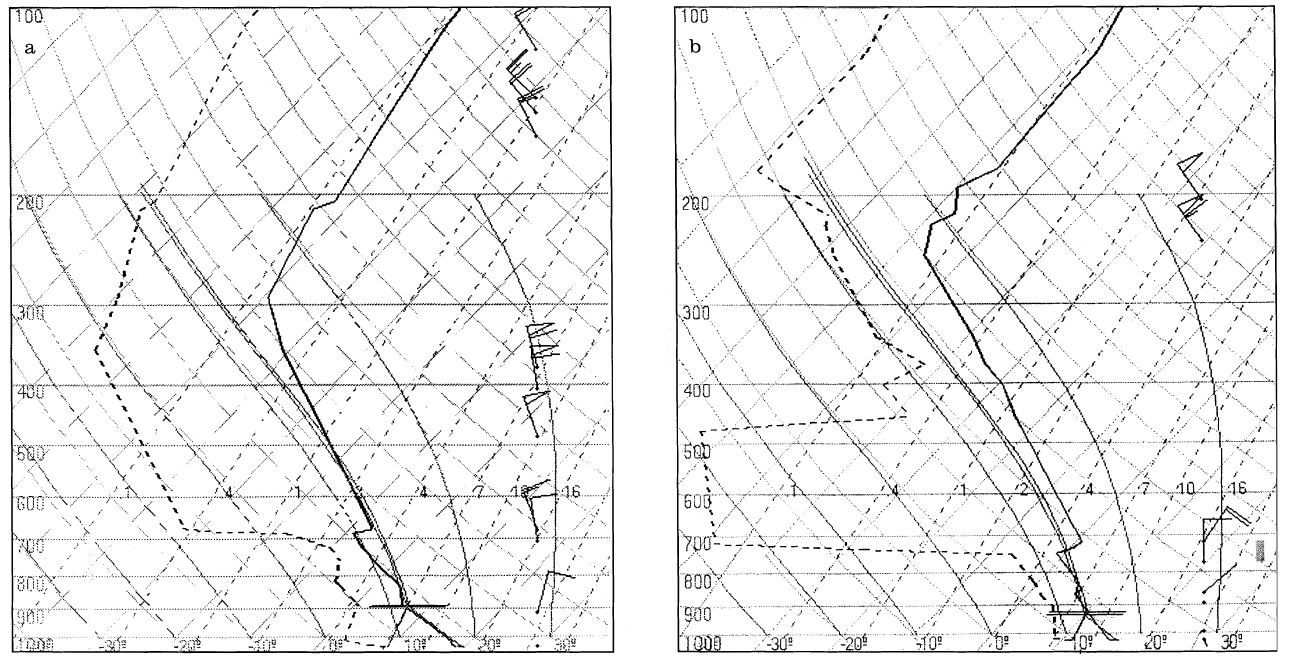
Fig. 4a,b. Skew T -log p plot for 1200 UTC on 15 March 1990 for a Palma de Mallorca sounding; b Murcia sounding. Solid line is the temperature; dashed line is the dewpoint. Wind barbs are in